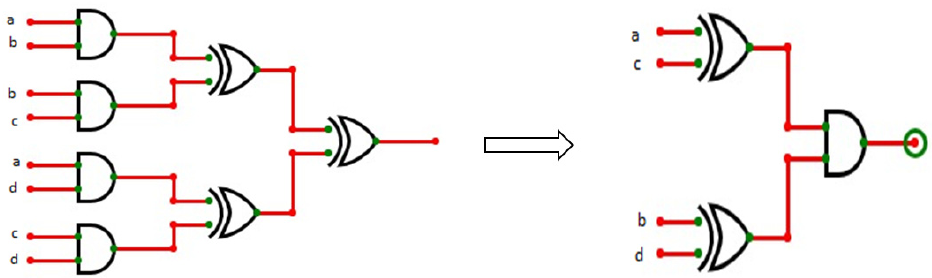
Figure 5. Sample structure for MPPRM architecture.